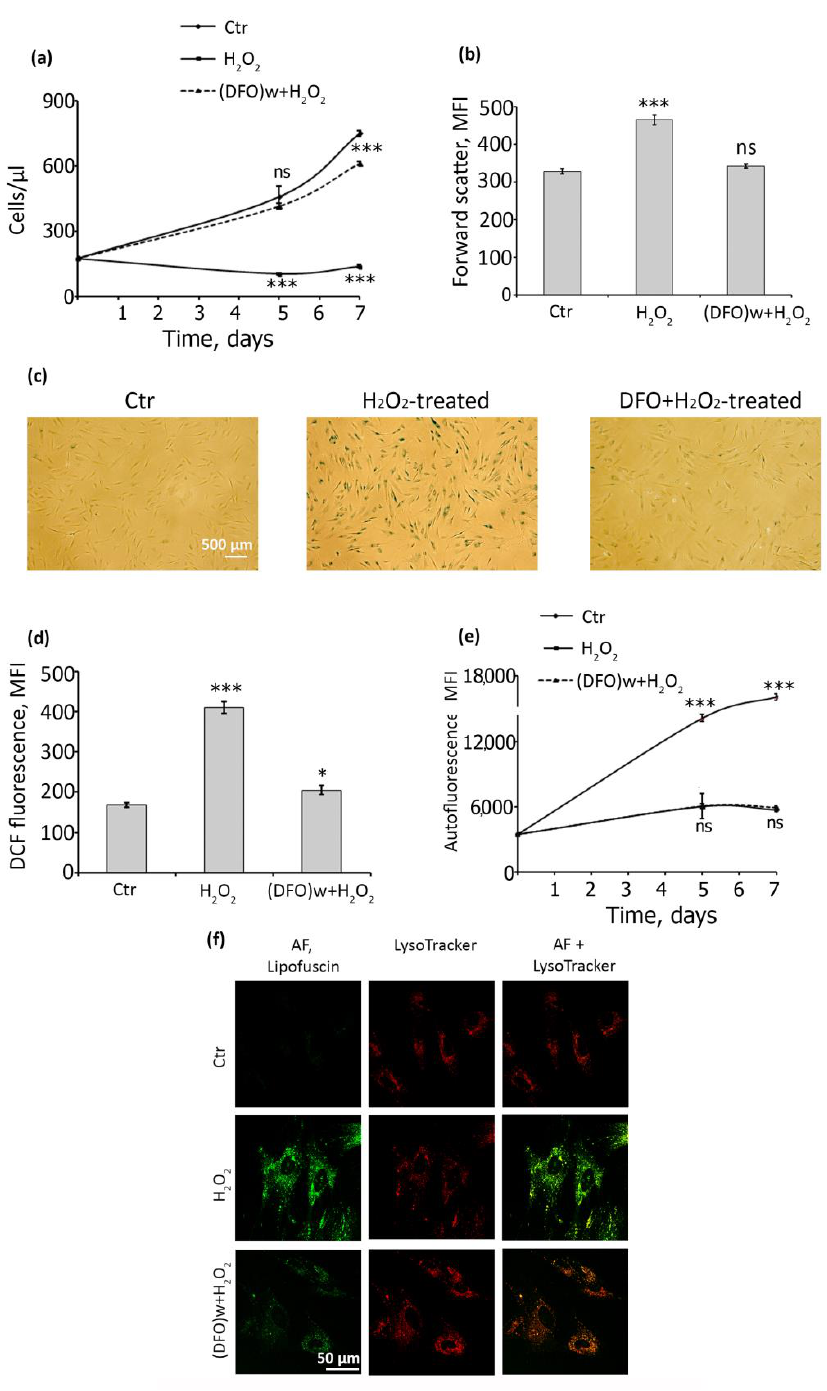
Figure 2. DFO pretreatment is sufficient to prevent H 2 O 2 -induced senescence of hMESCS. ( a ) Growth curves of the control, H 2 O 2 -treated and (DFO + H 2 O 2 )-treated cells estimated on the 5th and 7th days after the stress. ( b ) Forward scatter reflecting cell size analyzed on 5th day after the oxidative insult. ( c ) Representative microphotographs of SA- β -Gal staining. Scale bar 500 µ m is valid for all images. ( d ) Intracellular ROS levels assessed by FACS using dichlorodihydrofluorescein diacetate (DCF) staining. ( e ) Lipofuscin accumulation estimated by AF measurement. Data are shown as Mean ± SD, n = 3; *** p ˂ 0.005, * p < 0.05. ( f ) Effect of DFO on H 2 O 2 -induced accumulation of lipofuscin and its co-localization with lysosomal compartment in hMESCs. Cells were stained with the vital dye LysoTracker Red to detect lysosomes. To identify lipofuscin, which has a broad spec- trum of autofluorescence, we used 510–550 nm excitations light to visualize cells in real time using confocal microscopy.